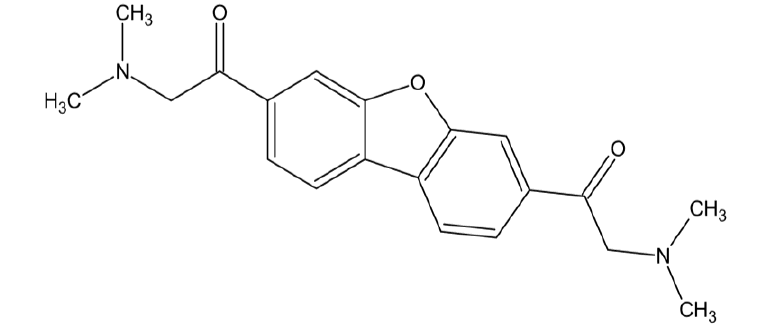
Figure 11. Repeat unit for the product of potassium tetrachloroplatinate II and tilorone 11,567.